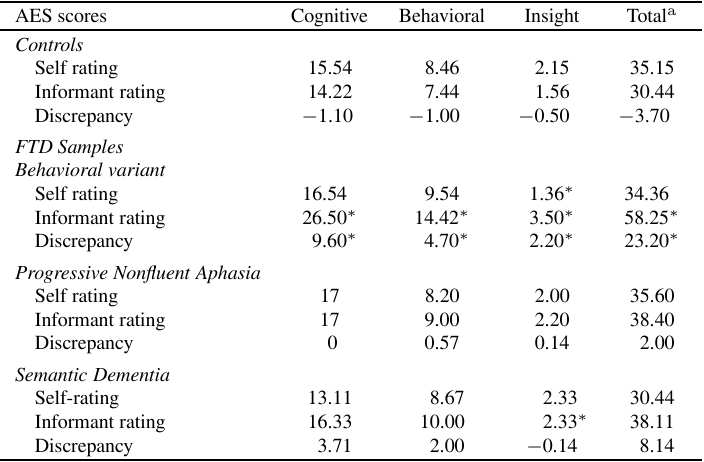
Table 2 Apathy Evaluation Scale (AES) scores for FTD clinical subgroups and the